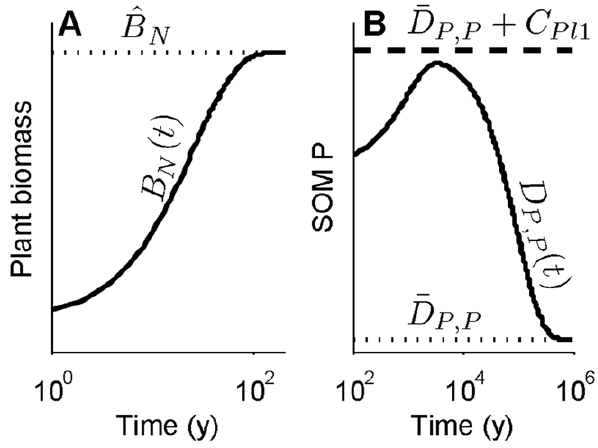
Figure 3. Examples of transient dynamics with single or double saturation rates. (A) On the intermediate timescale, N-limited plant biomass (solid curve) approaches its quasi equilibrium (dotted line) at the rate m N 9 (equation 9, which is the exponent in equation 11). With a logarithmic time axis (as here) this appears sigmoidal, but with a linear time axis it would be a saturating curve (similar to the Michaelis- Menten, or Type II, curve). P-limited plant biomass would have the same shape. (B) When NPP is P limited on the long timescale, SOM P has two controlling rates, the SOM P loss rate ( m P (1 2 k d P ) + Q P < Q P ) and the P weathering rate ( y , equation 17). When these are sufficiently different, SOM P (solid line) first approaches an intermediate quasi equilibrium (dashed line) at the SOM P loss rate, then proceeds to its equilibrium (dotted line) at the P weathering rate. Here the rates are different enough to yield an overshoot, but not sufficiently different to yield full quasi equilibration at the intermediate point. Other details of timescale dynamics are given in Figure S1.